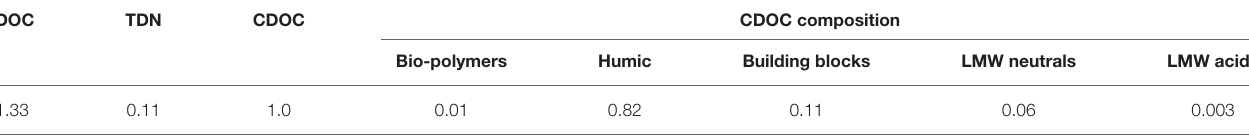
TABLE 3 | LC-OCD quantitative analysis of abundance (mgg − 1 ) of organics in biochar extract (DOM).